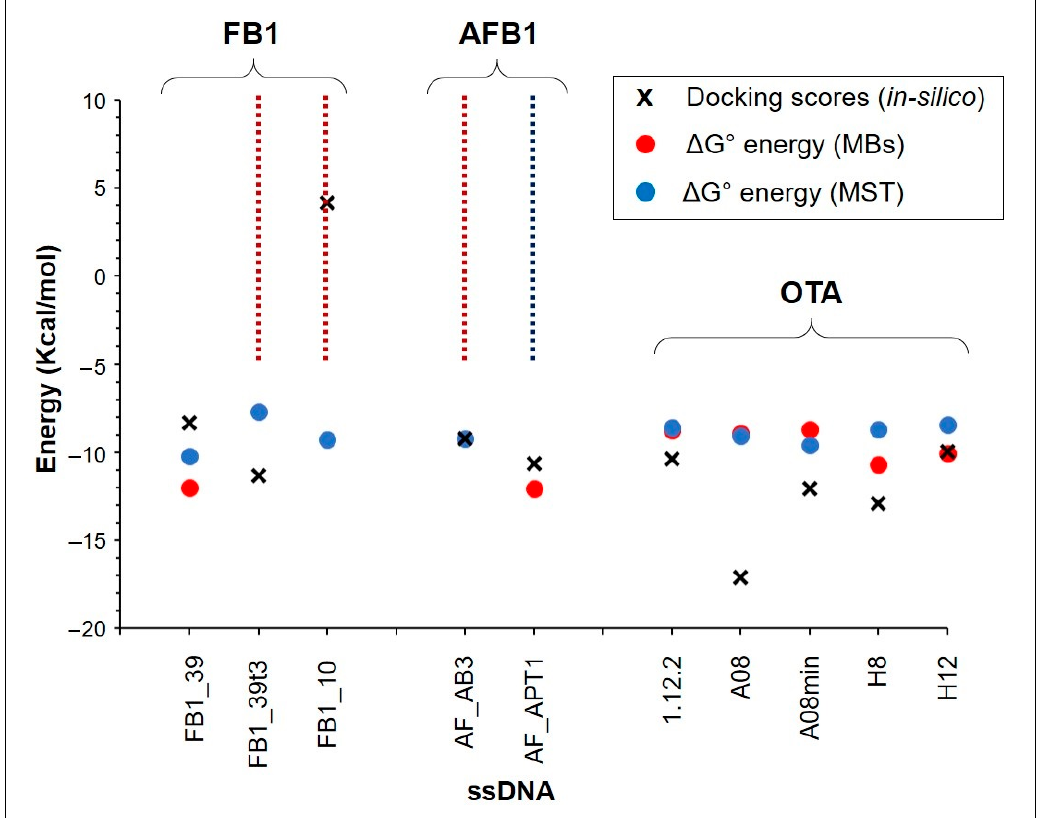
Figure 6. Comparison of experimental a ffi nity values ( ∆ G 0 energy, kcal / mol) and in-silico a ffi nity prediction (best estimated ∆ G 0 , kcal / mol) as obtained from docking score plus configurational aptamer energy. The dashed line indicates the lacking data for MST (blue line) or MBs (red line)